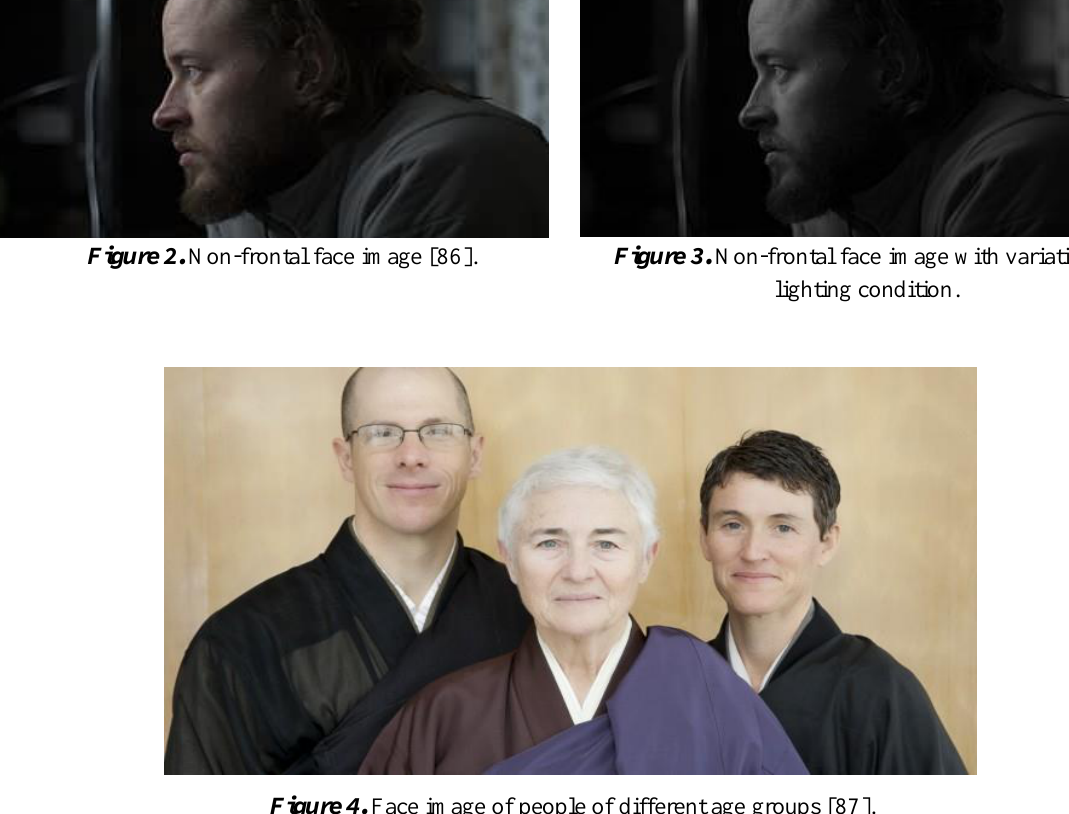
Figure 4. Face image of people of different age groups [87].